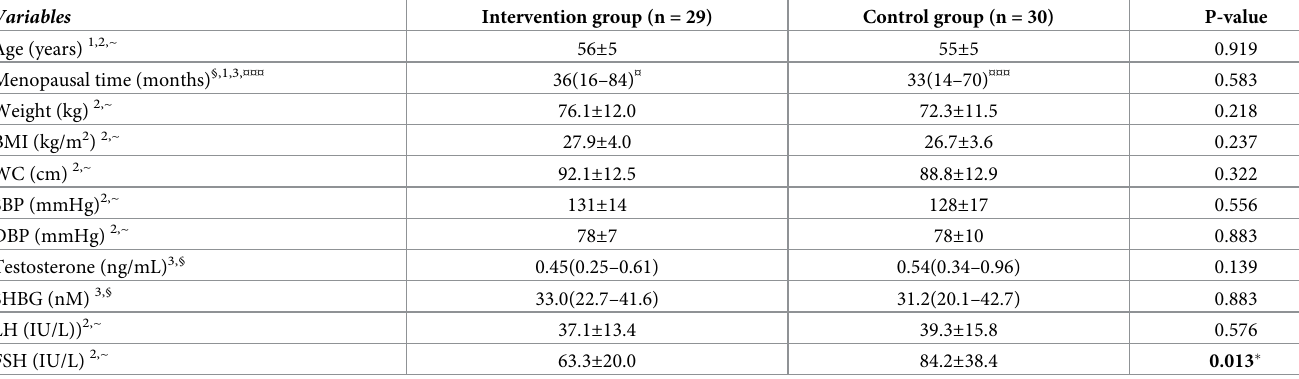
Table 2. Baseline characteristics of the original randomisation